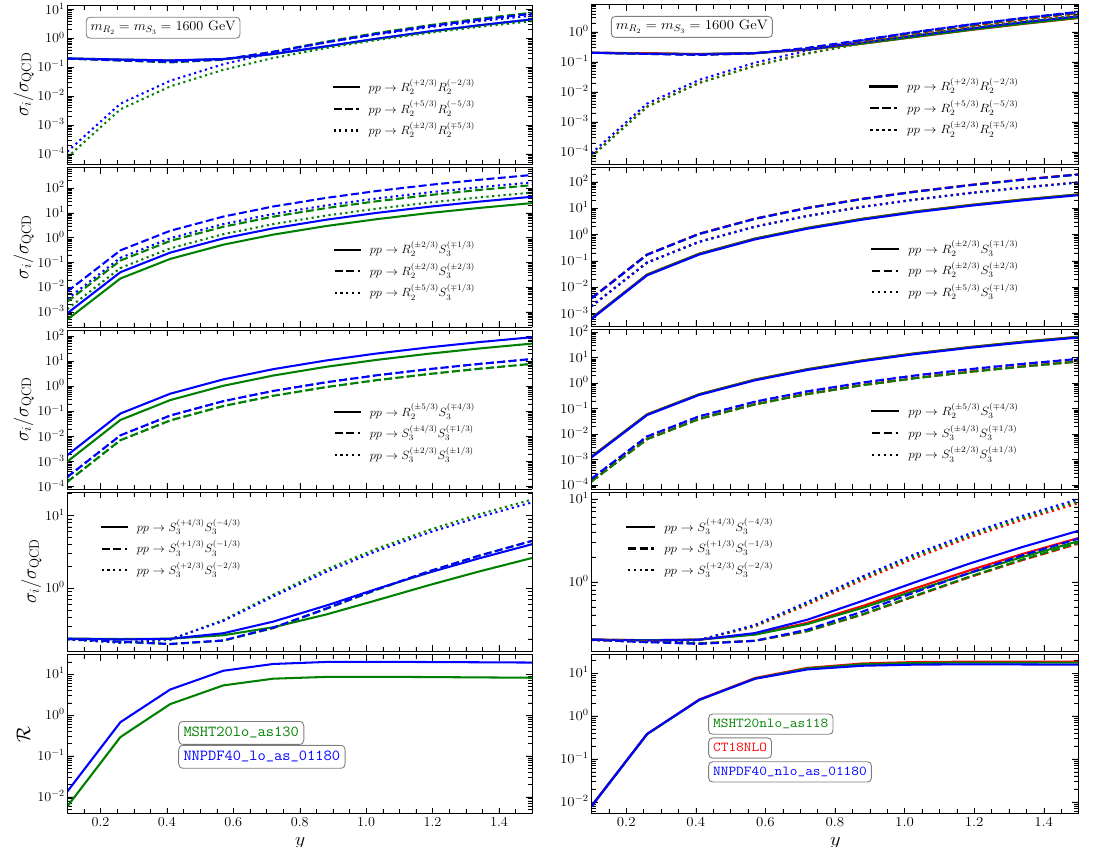
Figure 7 . Upper four panels : ratios of the different scalar leptoquark pair production cross section with respect to the pure QCD contribution as a function of y = y LR and NLO (right). σ QCD is defined as the sum of the cross sections for all diagonal channels with y = 0 , all predictions correspond to m R off-diagonal production rate to (full) the diagonal one as a function of y